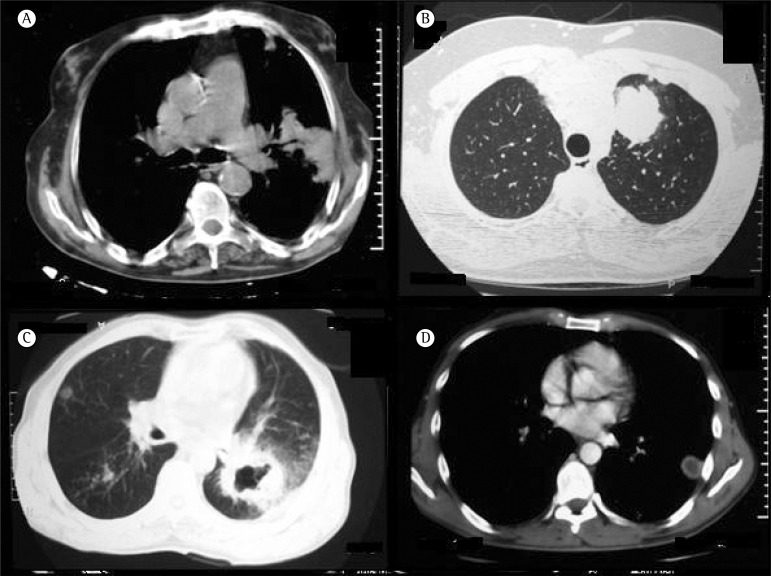
Helical CT scans showing an irregular lung mass (in A; male patient, 77
years old), a bosselated lung mass (in B; male patient, 30 years old), a
spiculated lung mass (in C; male patient, 64 years old), and a regular lung
mass (in D; male patient, 36 years old)